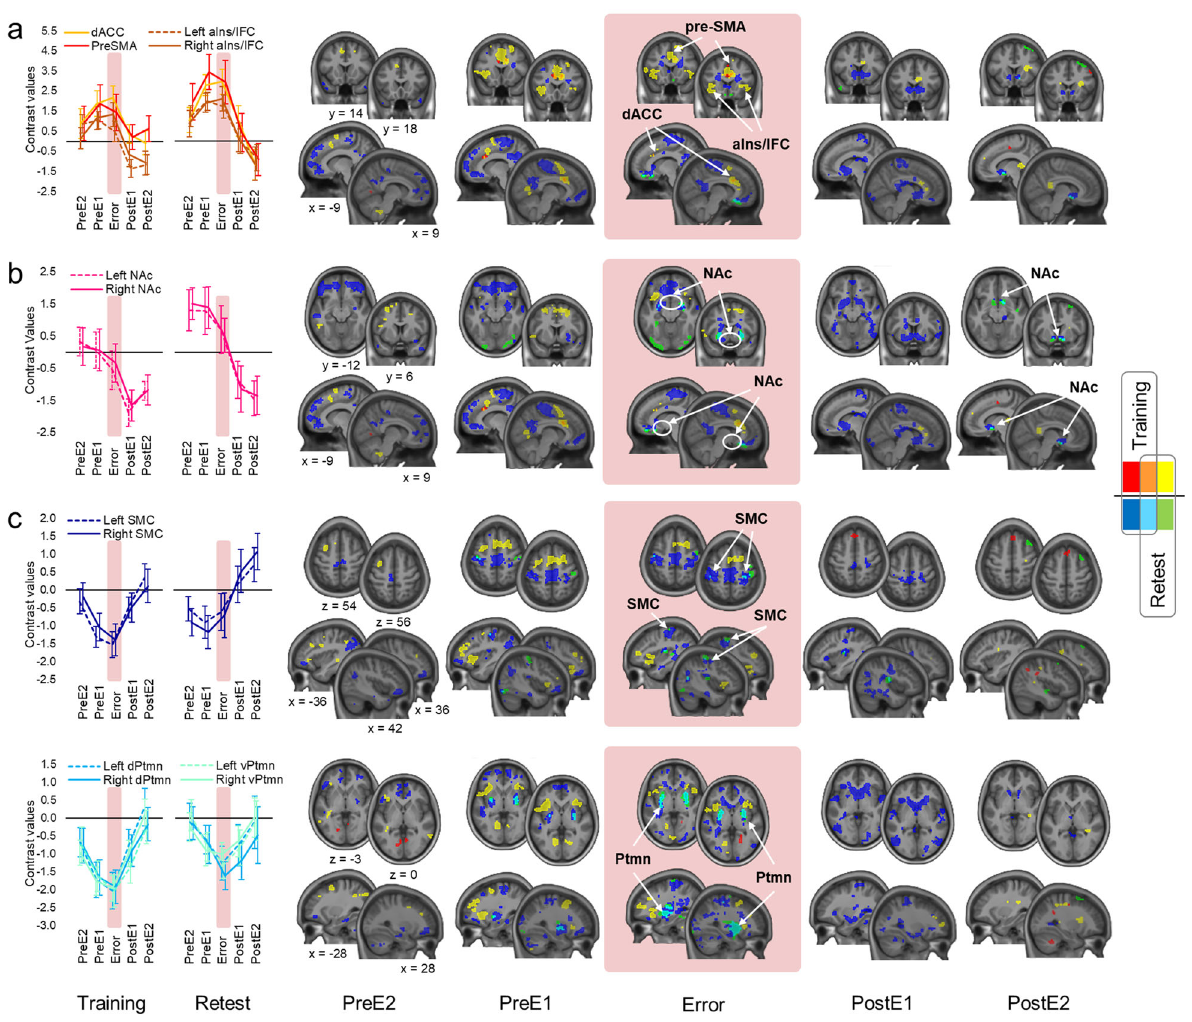
Fig. 7 Reproduction and replication study. Areas with a increased activity during errors, b decreased activity during post-error performance recovery, and c decreased activity during errors. We used the same regions of interest (ROIs) as in our main study (Table 3). Activity levels in both ROI-based and whole-brain analyses are estimated relative to the control error-free task condition (zero values along the x -axis). Data points represent mean contrast values. The results of the whole-brain analyses were thresholded at p < 0.005. Red/blue and yellow/green clusters — activity increases/decreases associated with error processing during the training and retest, respectively; orange/cyan clusters — overlap. The abbreviations for brain regions are the same as in Fig. 5. PreE2 and PreE1 — two consecutive sequences before the error, PostE1 and PostE2 — two consecutive sequences after the error. Error bars represent standard error of the mean